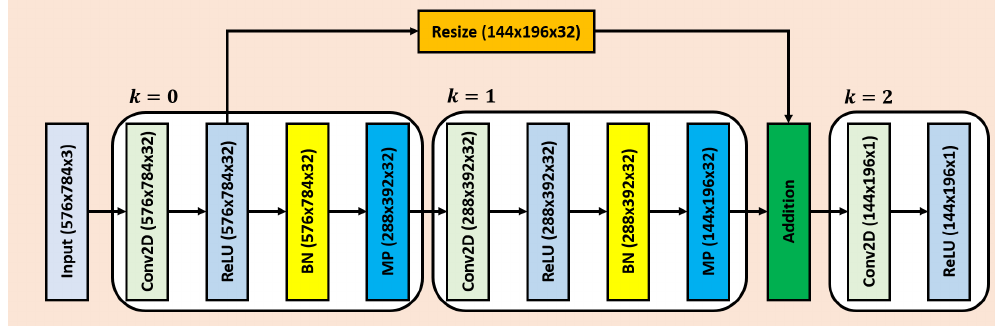
Figure 3. Salient network architecture. The abbreviations are Conv2D: 2D Convolution, BN: Batch Normalization, and MP: Max